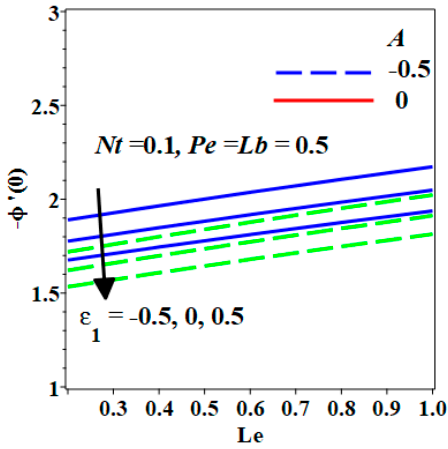
Figure 8. Variation of A , Le and ε 1 on − φ (cid:48) ( 0 ) .